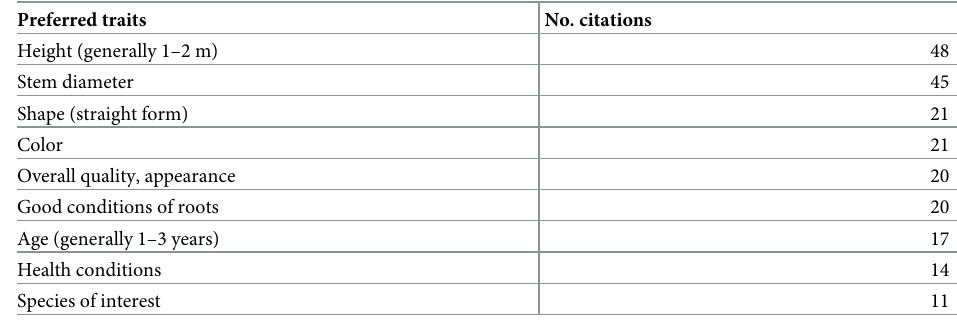
Table 8. Traits influencing the selection of planting material from the forest. Preferred traits No. citations Height (generally 1–2 m) 48 Stem diameter 45 Shape (straight form) 21 Color 21 Overall quality, appearance 20 Good conditions of roots 20 Age (generally 1–3 years) 17 Health conditions 14 Species of interest 11 Traits cited > 10 times by respondents were considered.